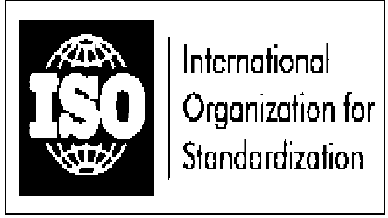
Fig. 4. ISO - International Organization for Standardization.